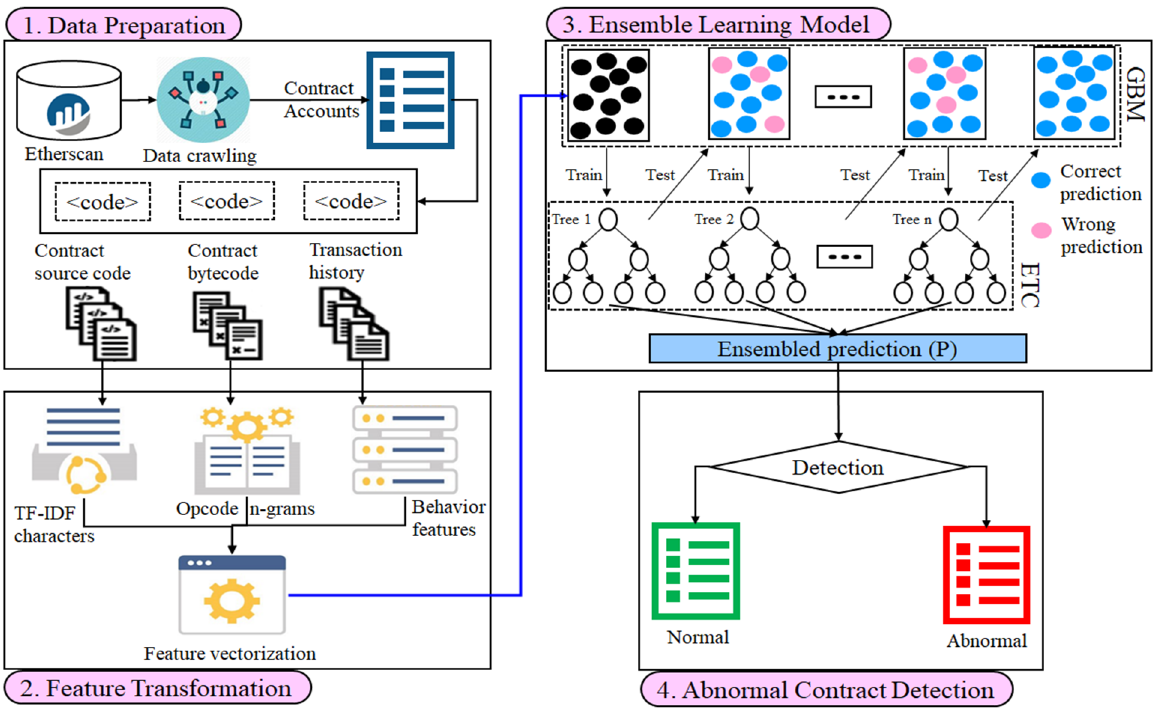
Figure 1. The schematic workflow of our proposed methodology for the abnormal contract detec-